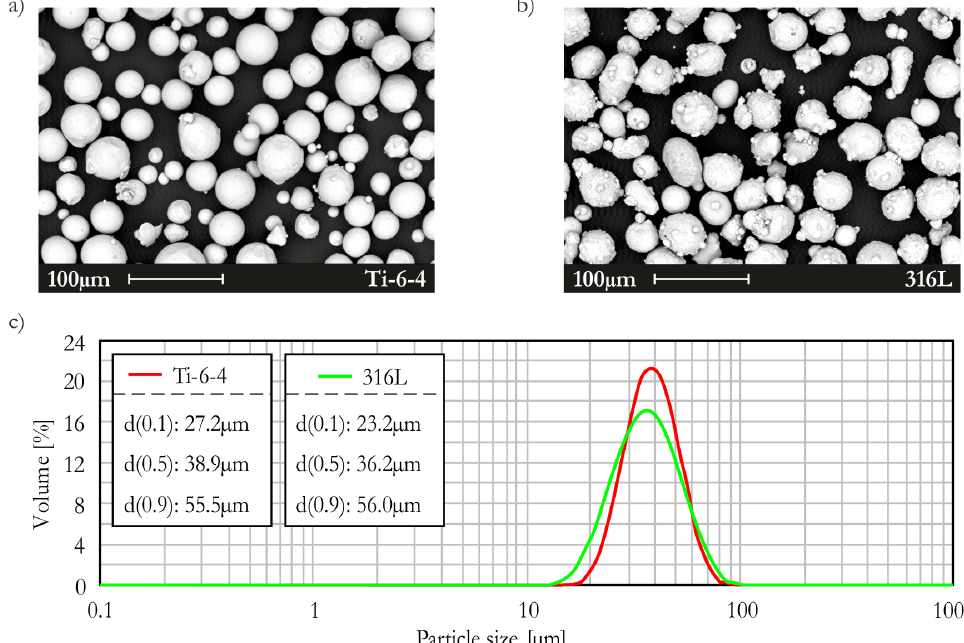
Figure 2: Metallic powder for SLM process. Scanning electron microscope images of titanium alloy powder particles a) and stainless steel powder particles b). The average particle sizes as well as the particle size distribution are depicted in c).